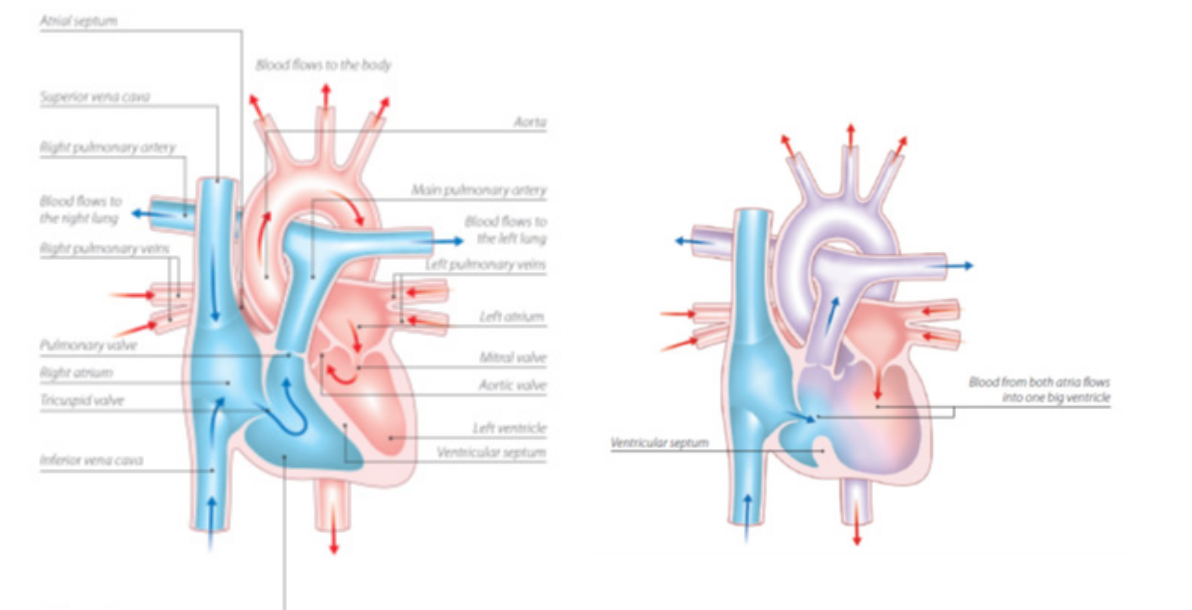
Figure 1b. Heart with Double Inlet Left Ventricle; Understanding your child's heart - Double inlet ventricle (British Heart associa- tion. 1st ed. 2016, cited 28 November 2016. Available from: https:// www.bhf.org.uk/publications/children-and-young-people/unders- tanding-your-childs-heart---double-inlet-ventricle). Reprinted with permission from British Heart Association